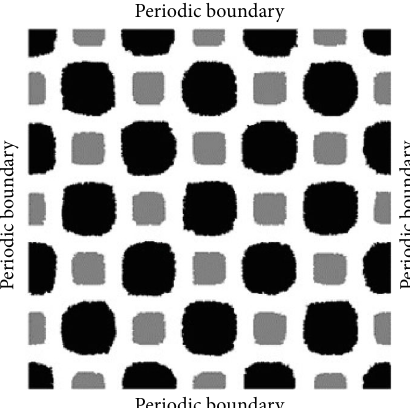
Figure 2: 2D distribution of hydrate and solid particles. The hydrate pore habit is pore- fi lling. The hydrate and solid particles are shown in black and gray,